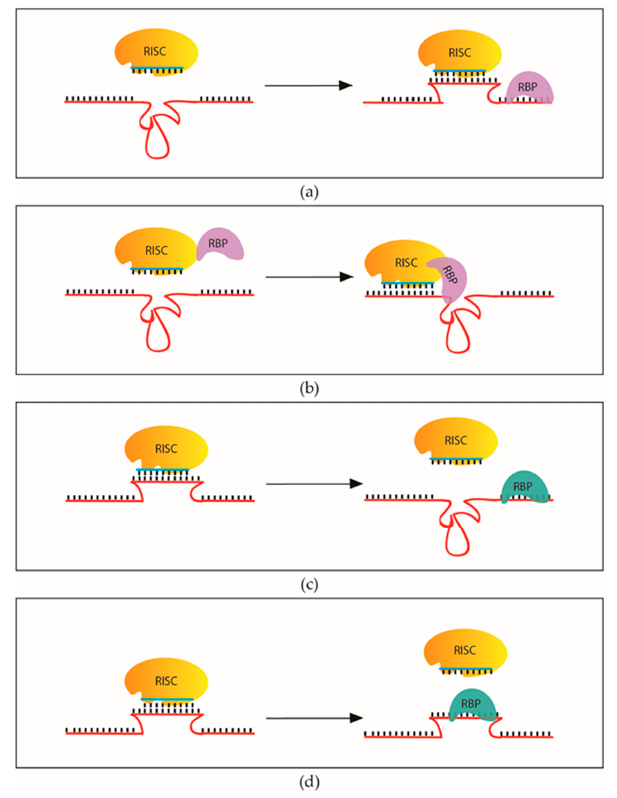
Figure 3. RNA binding proteins can promote and inhibit miRNA action. ( a ) Restructuring the target RNA by RBPs could result in miRNA targeting; ( b ) RBPs assisting miRNA targeting via direct binding to RNA induced silencing complex (RISC); ( c ) RBPs could restructure the target RNA and prevent miRNA targeting; ( d ) RNA binding proteins (RBPs) and miRNA complexes can compete to target the same mRNA via overlapping target sites.